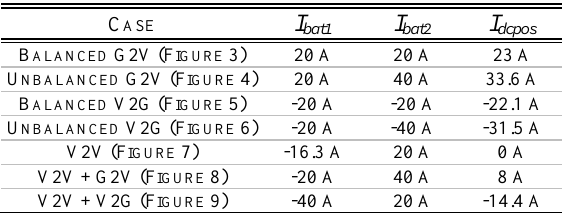
Table 2. Average value of the currents obtained in the simulation